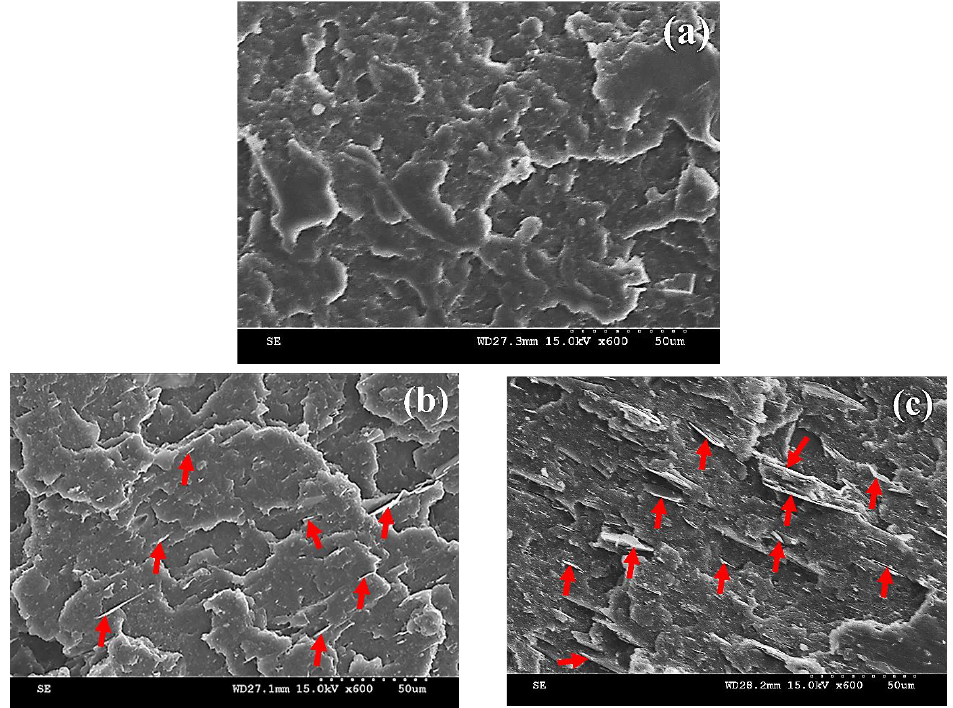
Figure 5. SEM images of the fractured surface of the ( a ) neat R-(PE/PP), ( b ) R-(PE/PP)/FLG = 96/4, and ( c ) R-(PE/PP)/FLG = 90/10. The arrows indicate a few of the FLGs, visible on the fractured surface of the R-(PE/PP)/FLG composites.